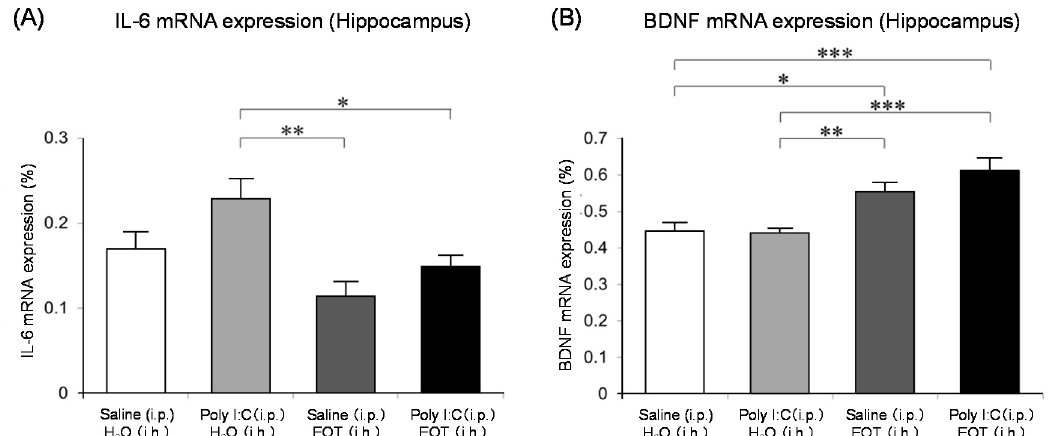
Figure 8. Effects of thyme on gene expression levels in the brain. Mice received i.p. injection of Poly I:C (20 mg/kg) or saline. After i.h. of thyme (EOT) (2 mL/L air) or distilled water, hippocampus was used for RT-PCR analysis. ( A ): Interleukin-6 (IL-6) gene expression in the hippocampus. ( B ): BDNF gene expression in the hippocampus. The results are expressed as the ratio of mRNA expression level of IL-6 or BDNF to that of GAPDH (%), and are means ± SEM (n = 5–7). * p < 0.05, ** p < 0.01, *** p < 0.001 (Tukey–Kramer test). This figure is modified based on the original figure [121] with the copyright permission.